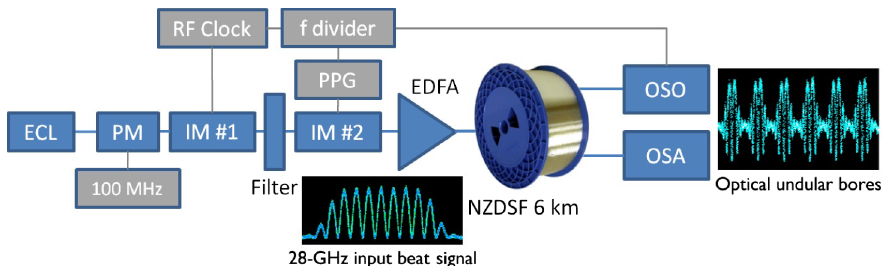
FIG. 3. Experimental setup. ECL: external cavity laser; IM: intensity modulators; PM: phase modulator; PPG: pulse pattern generator; OSO: optical sampling oscilloscope; OSA: optical spectrum analyzer; NZDSF: nonzero dispersion shifted fiber. The insets show traces of the input and output, as seen on the